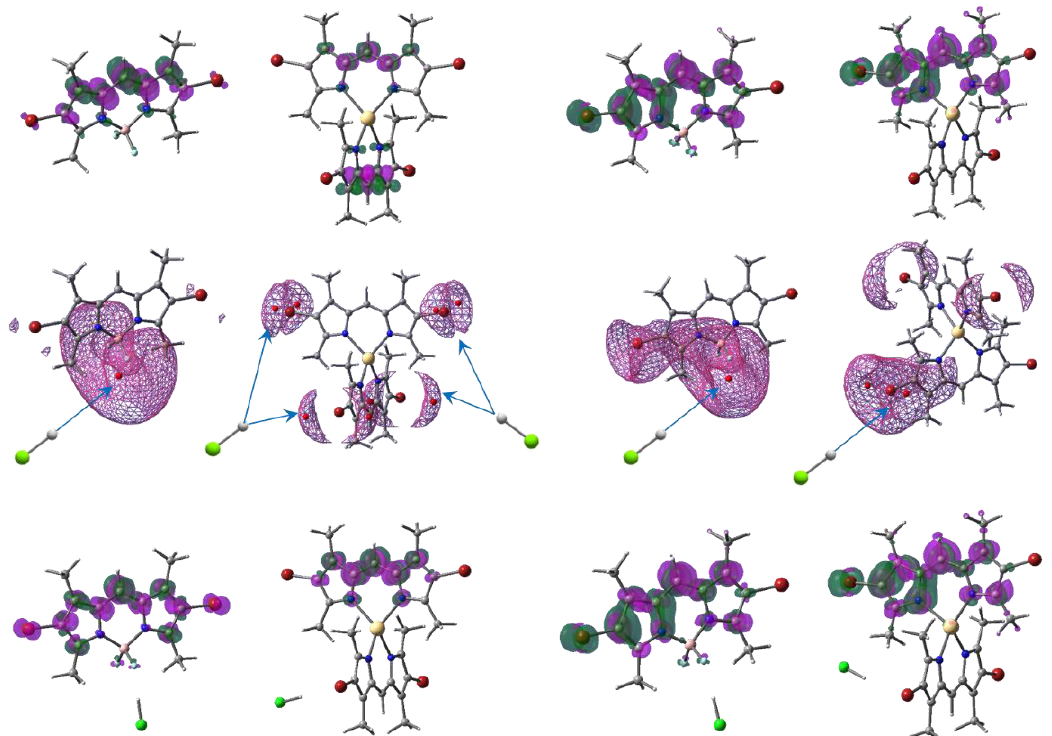
Figure 4. The uppermost pictures represent the ED redistribution (isodensity 2 × 10 3 e − /bohr 3 ) from the green to the magenta areas for the Br 2 (CH 3 ) 4 BODIPY and Cd[Br 2 (CH 3 ) 4 dpm] 2 absorption (left side) and their emission (right side) in neutral ethanol. Global ESP minima (red circles) inside the mesh isolines 0.44 eV, with preferable directions of proton attack, are presented below. The bottom images are the same as the uppermost ones, but for the acidified (HCl) compounds.